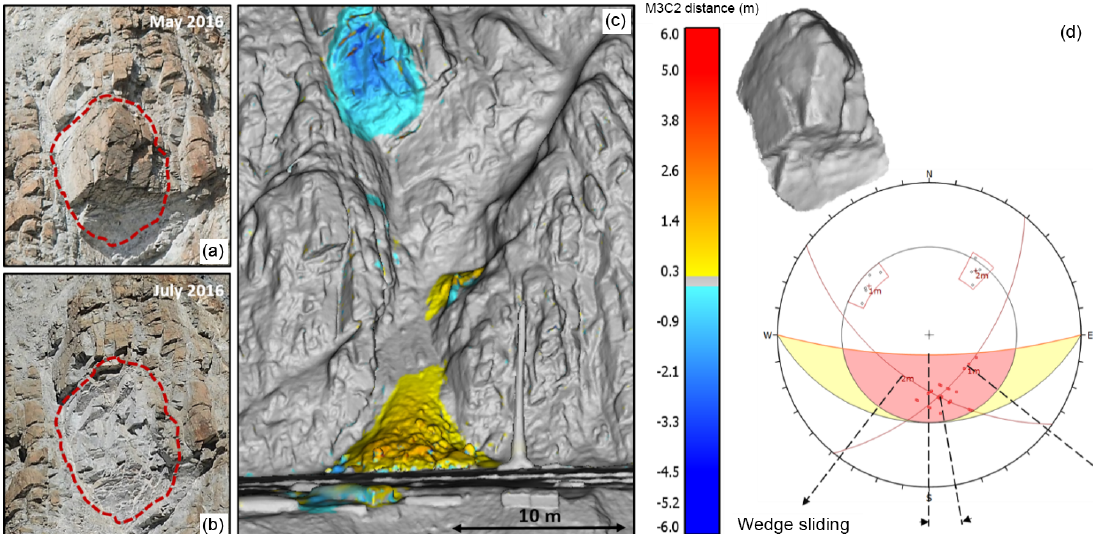
Figure 4. Site B. Visual overview of the 24m 3 wedge sliding rockfall event detected at the White Canyon East site between May and July 2016. The event involved a large pseudo-cubic block of weathered and jointed rock mass which failed approximately 46m above track level. Site photos (a, b) of the source zone pre- and post-failure are shown. Change detection results of the event are shown (c) with cool colours indicating material loss and warm colours indicating material accumulation. A small portion of the rockfall volume was retained in the gully leading down to track level, with the majority of the accumulation taking place in the track-side ditch. The rockfall hull of the event extracted from the pre- and post-failure meshes is shown (d) , as well as a stereonet representation of the wedge sliding failure mode. It should be noted that parts of the source rock mass also exhibited overhanging